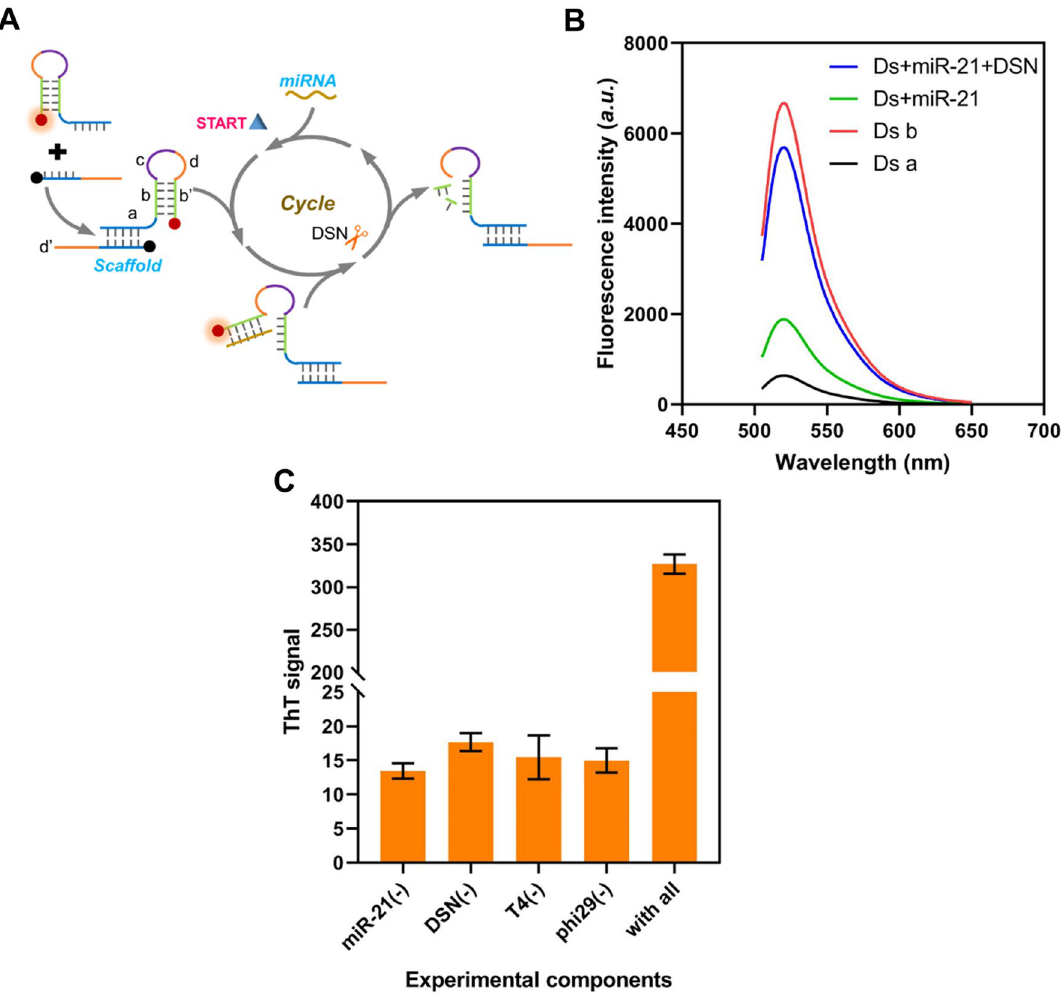
Fig. 2 Construction of detection scaffold and feasibility of DiRCA. A illustration of fluorescence assay to test the construction of detection scaffold. B fluorescence spectrum of FAM labeled detection scaffold. C ThT signals of DiRCA when each of experimental component existed or